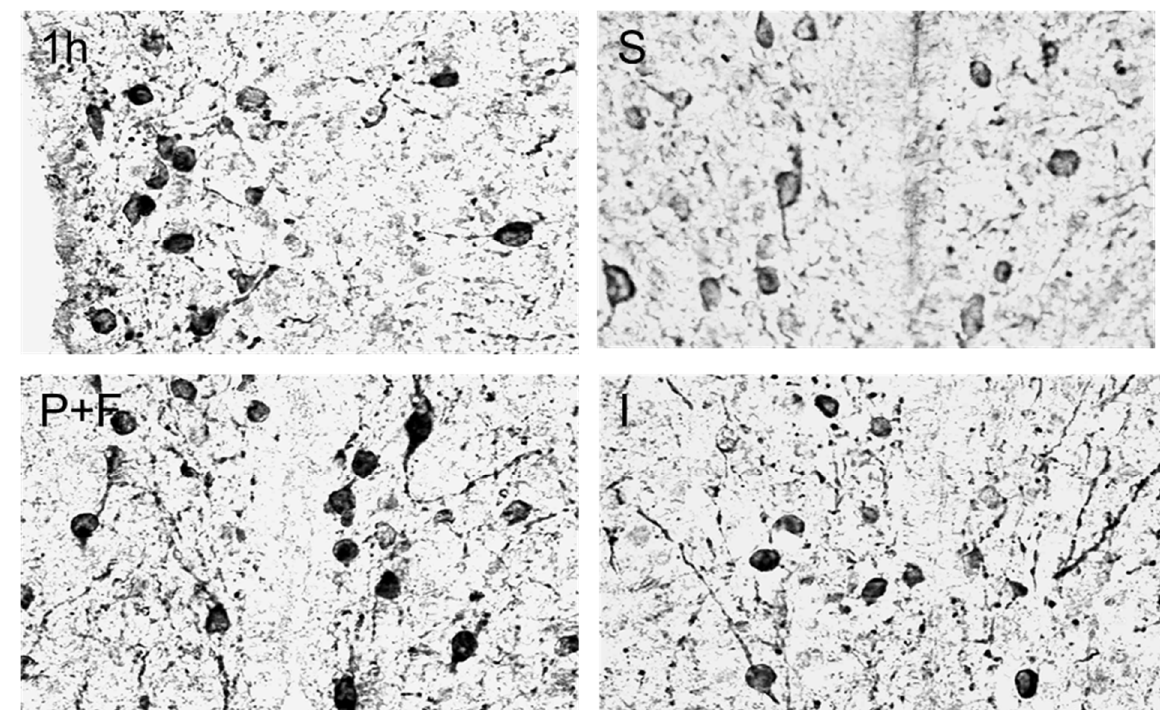
Figure A15. Tyrosine-hydroxylase immunoreactivity in the infundibular nucleus of Syrian hamsters. Comparison between 1 h manual sleep deprivation (1 h, group 3a), sleep (S, group 5), sexual stimulation with pheromone and females (P+F, group 1) and immobilization stress (I, group 4). Magnification: 200×.